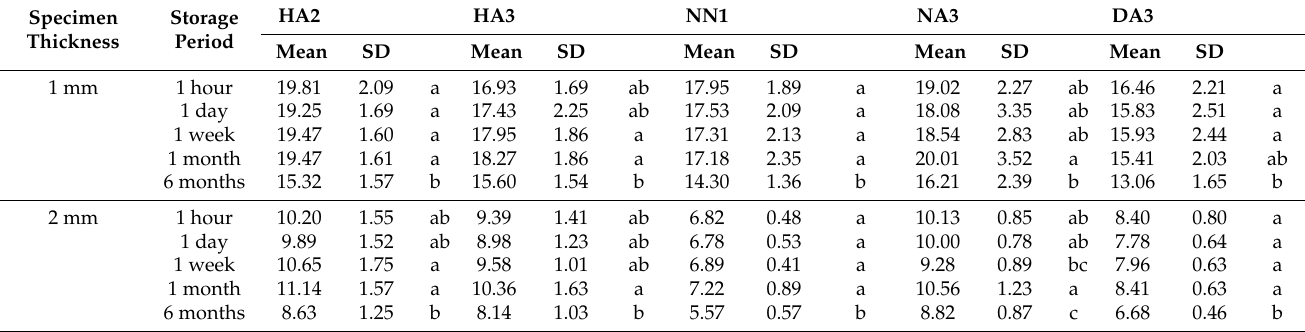
Table 5. Mean translucency parameter (TP) of the 3D printable material specimens after different storage periods. Specimen Thickness